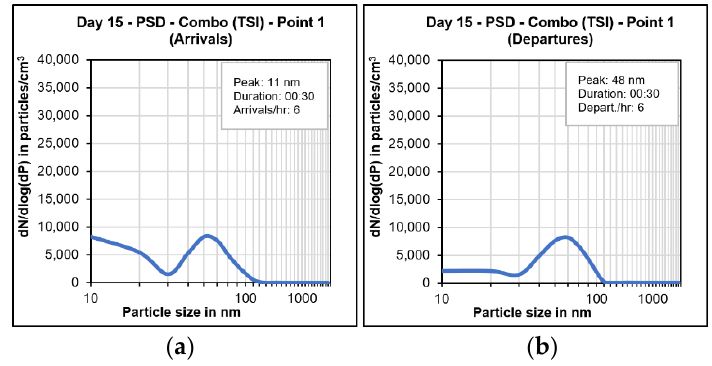
Figure 9. PSD on day 15 at point 1 of ( a ) arrivals and ( b ) departures.